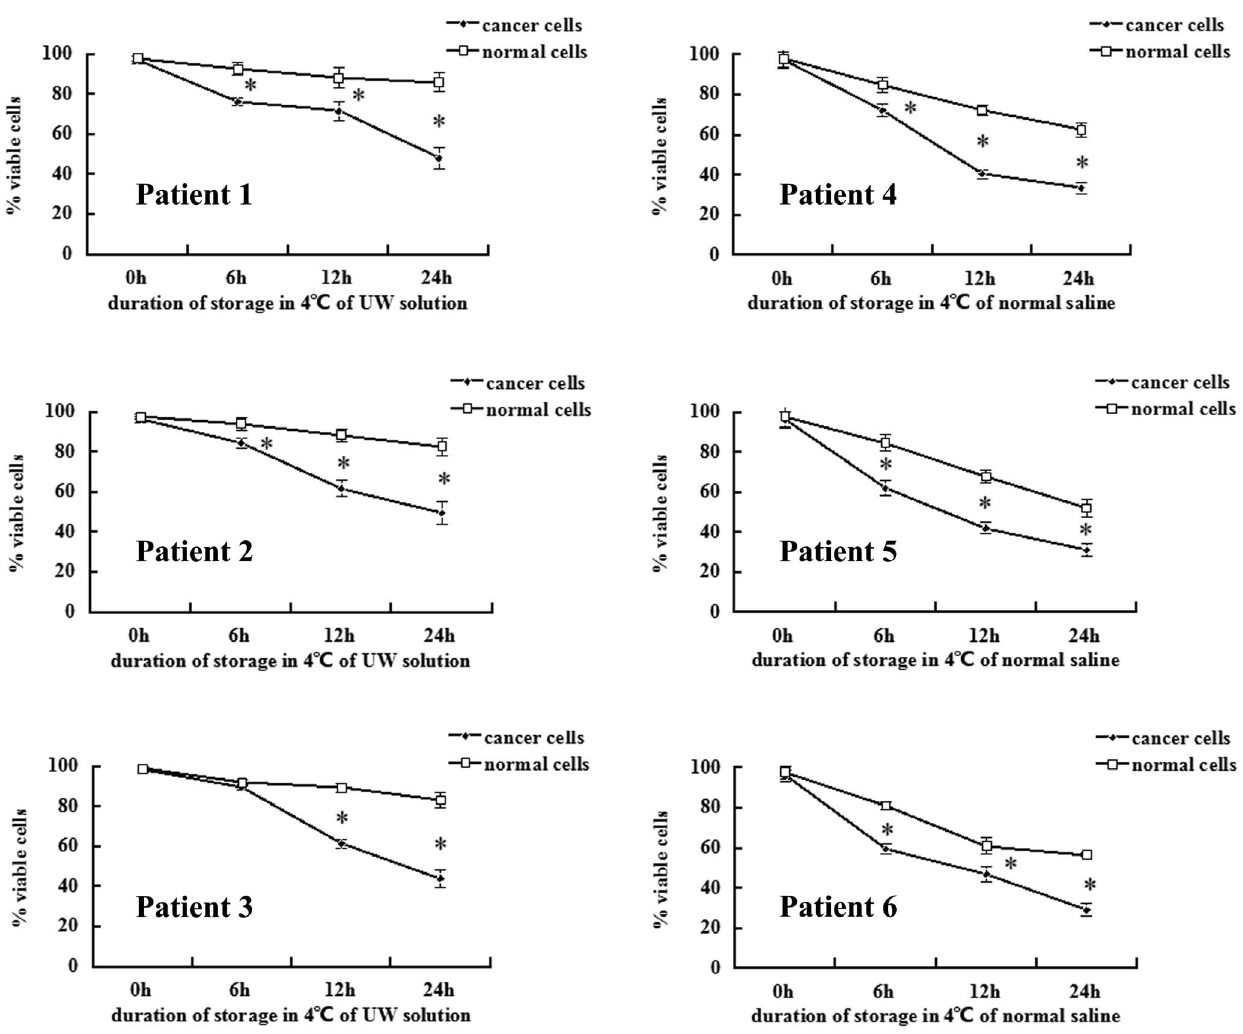
Figure 5. Percentage of viable cells after cold-storage in UW solution or normal saline. After culture for the indicated length of time, viable and dead cells were counted by Trypan Blue exclusion and microscopy. * p ,